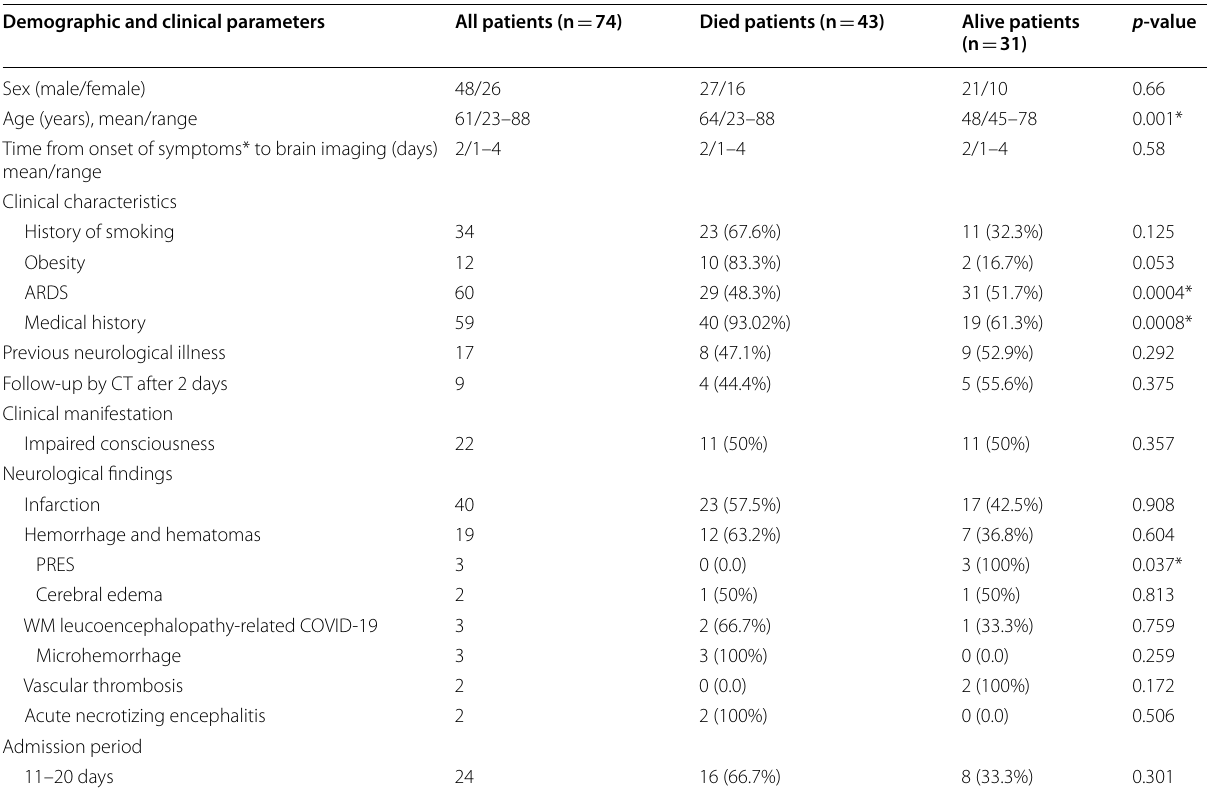
Table 3 Epidemiologic profile and clinical